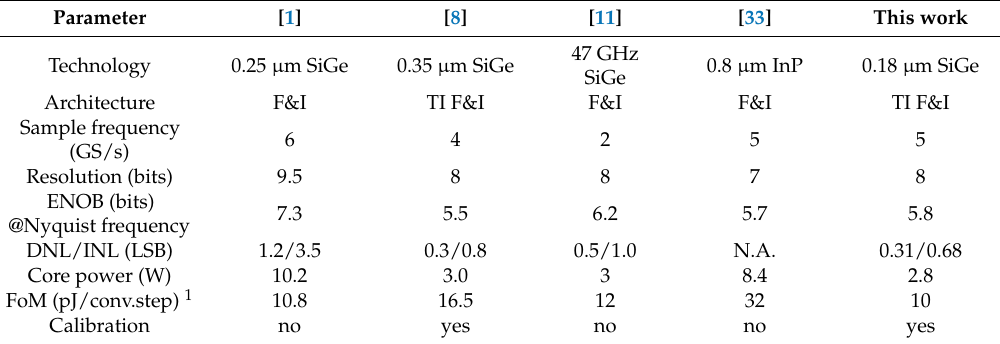
Table 1. Comparison of the analog-to-digital converter (ADC) performance.